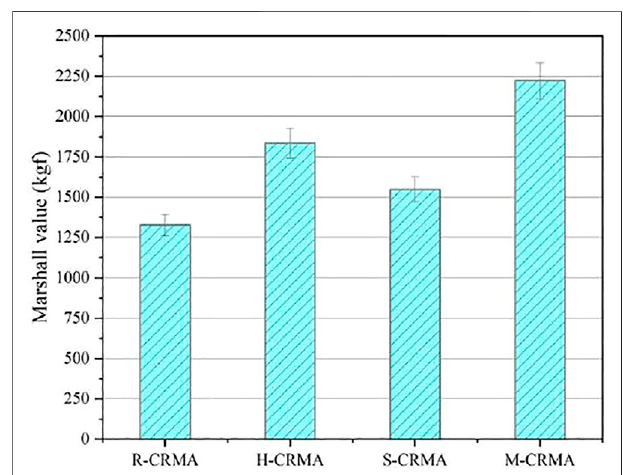
FIGURE 7 | Marshall stability of crumb rubber-modi fi ed